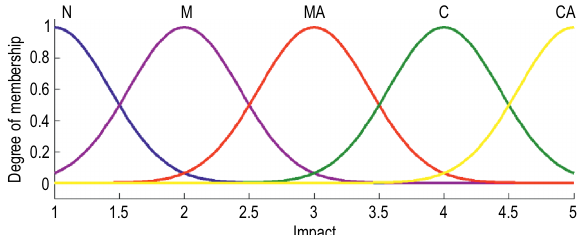
Fig. 5. Membership function for impact levels